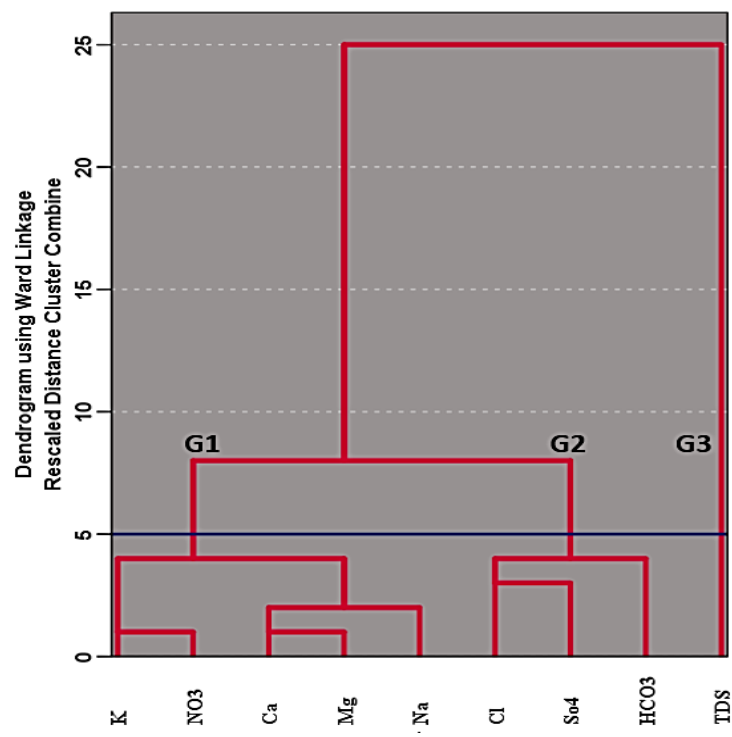
Figure 11. Cluster dendrogram for variables.